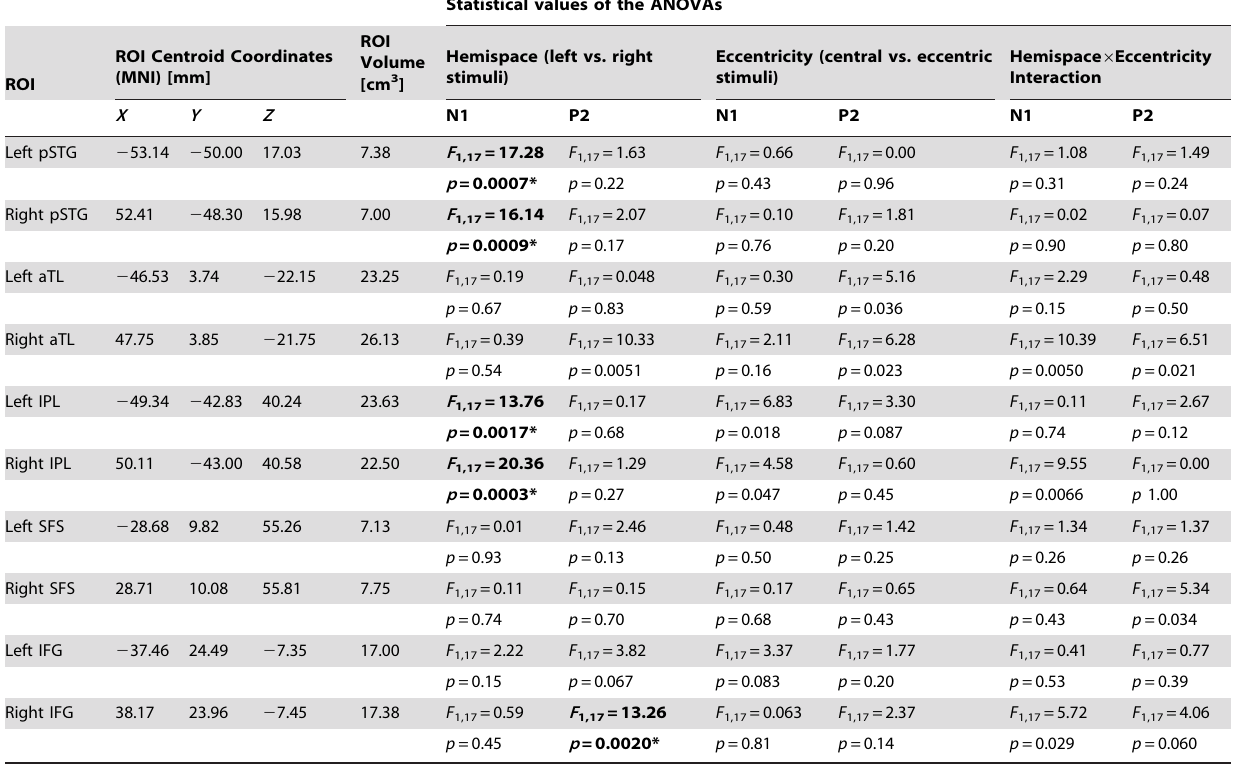
Table 1. Results of two-factor ANOVAs comparing either N1 or P2 responses to central (azimuth from 6 10 u to 6 40 u ) and eccentric (from 6 50 u to 6 80 u ) sound stimuli (factor ‘‘Eccentricity’’) and stimuli on the left (from 2 80 u to 2 10 u ) and right (from 10 u to 80 u ; factor ‘‘Hemispace’’) in 10 regions of interest